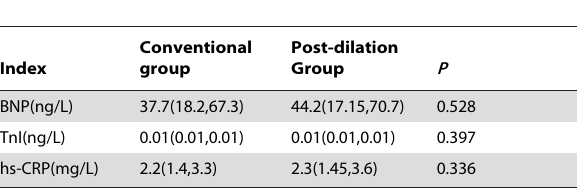
Table 6. Pre-procedural levels of BNP, TnI and hs-CRP between both groups